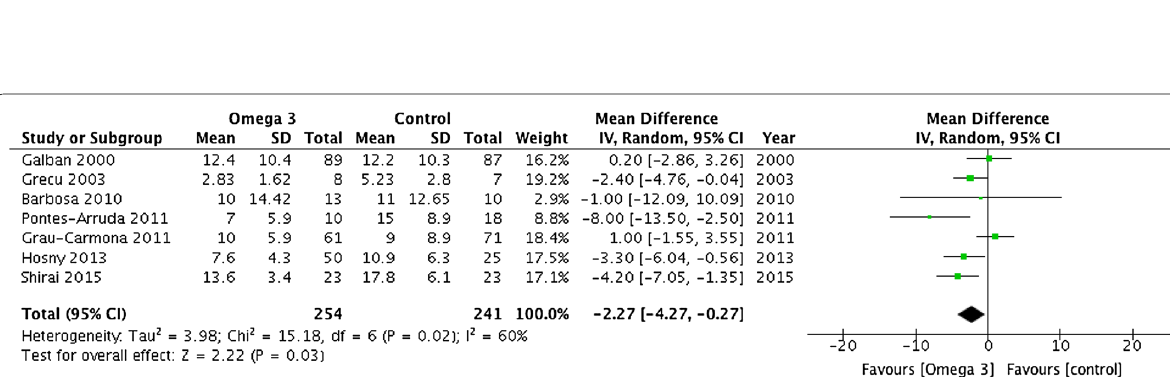
495 patients) were included and analysed using the random-effects =